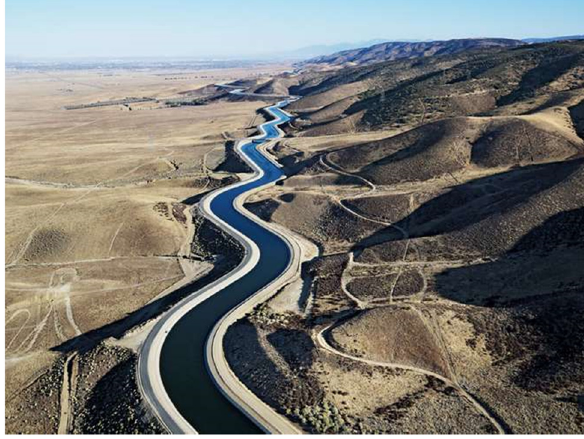
Figure 1: The Los Angeles aqueduct carries water from the Owens Valley to Los Angeles, California [ 2 ]